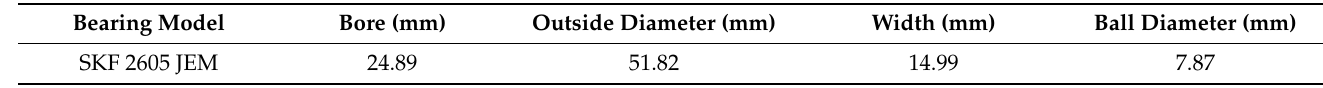
Table 1. Ball bearing